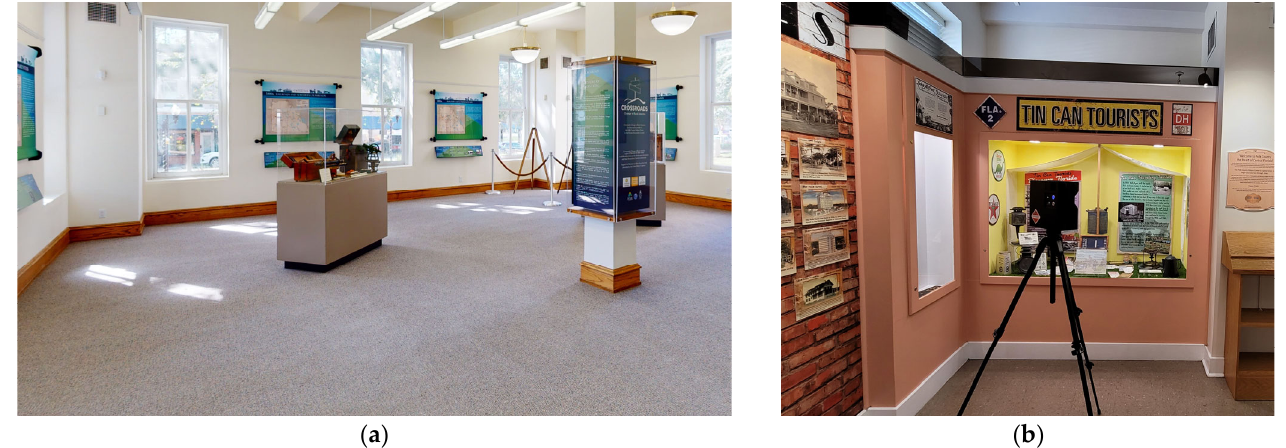
Figure 4. Three-hundred-and-sixty-degree photography and immersive virtual tours: ( a ) a screenshot of a virtual tour of a historic courthouse; ( b ) capturing a virtual tour of the historic courthouse with a 3D camera.